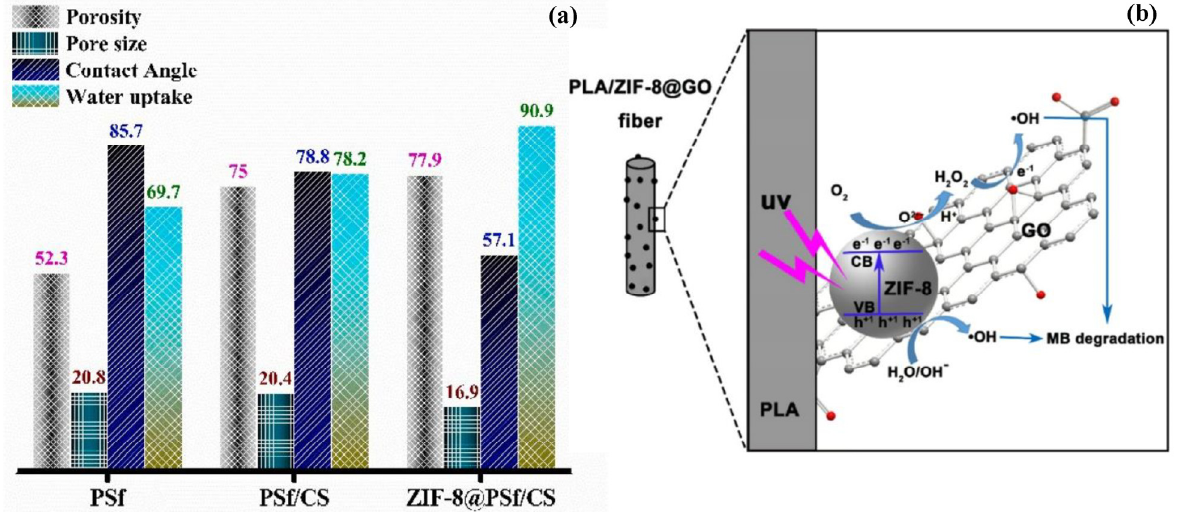
Figure 10. Integration of new membrane properties due to ZIF–8 addition: ( a ) Enhanced hydrophilicity in ZIF–8 modified membrane [280] , © Elsevier, 2022; ( b ) Possible mechanism for ZIF–8 mediated photocatalytic degradation of methylene blue [69] , © ACS Omega, 2018.